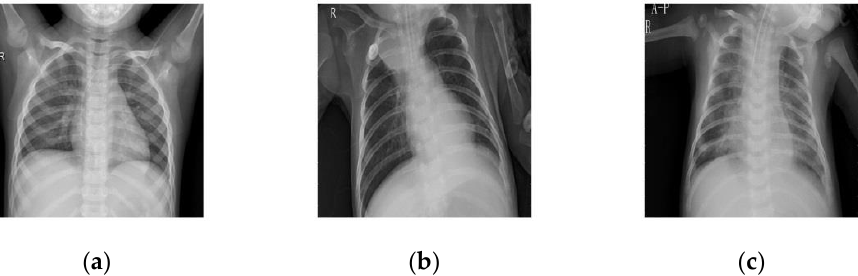
Figure 5. Original CT image dataset, ( a ) Noiseless CT1 image; ( b ) Noiseless CT2 image; ( c ) Noiseless CT3 image